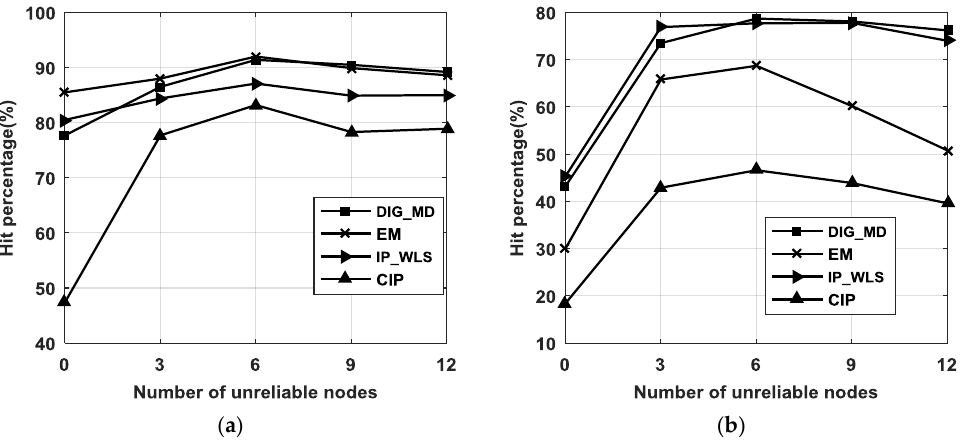
Figure 7. ( a ) Hit percentages of the DIG_MD, EM, IP_WLS, and CIP methods compared with the PLE when σ 1 = 2 ◦ and σ 2 = 15 ◦ , and m = 4; ( b ) hit percentages of the DIG_MD, EM, IP_WLS, and CIP methods compared with WLS when σ 1 = 2 ◦ and σ 2 = 15 ◦ , and m =